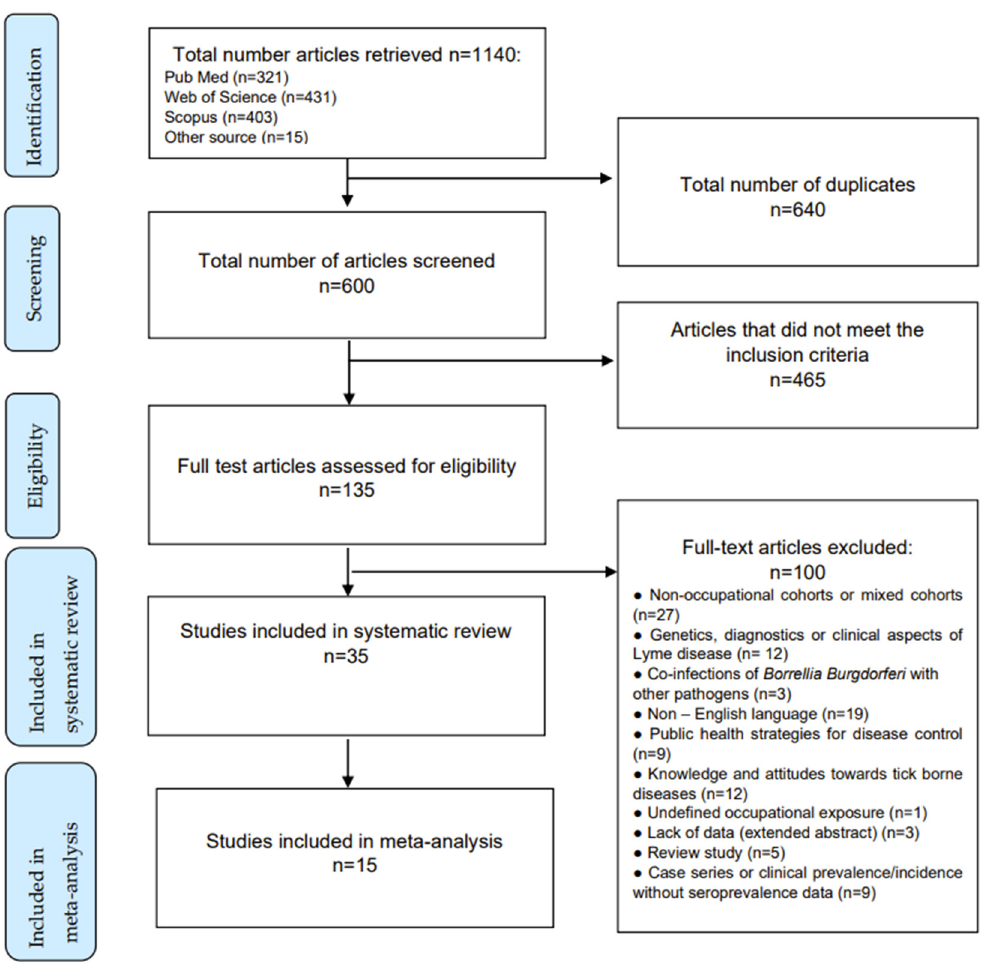
Figure 1. Article selection algorithm (PRISMA 2009).